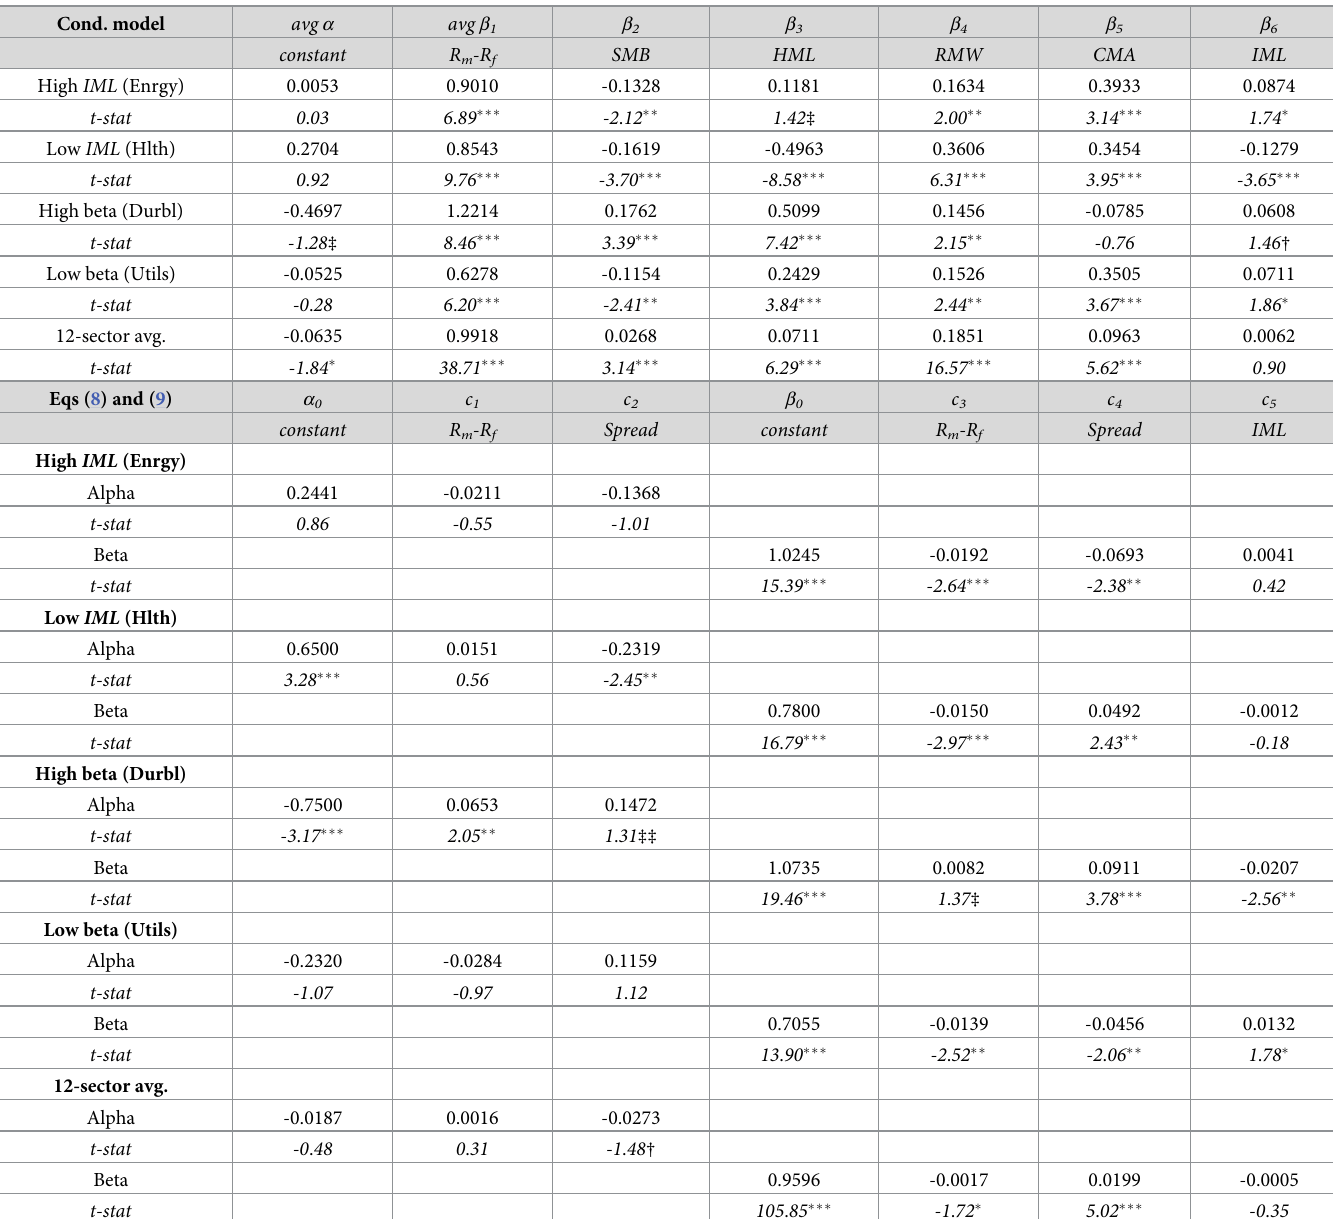
Table 3. Parameter estimations for the conditional Fama-French model via OLS by liquidity and beta attributes. Cond.